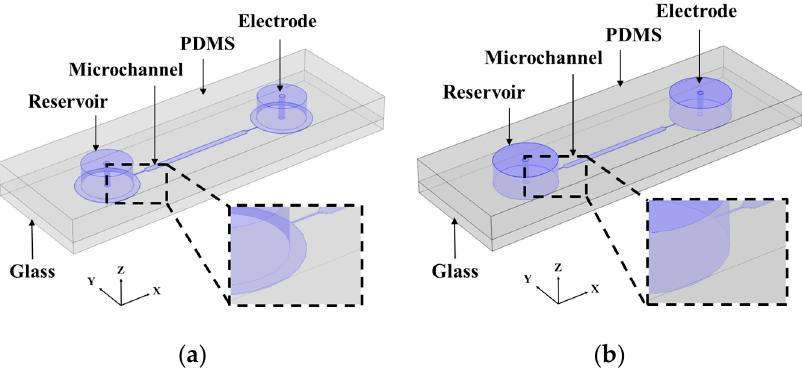
Figure 1. Conceptual schematic of the two-dimensional reservoir-based dielectrophoresis (2DrDEP) and three-dimensional reservoir-based dielectrophoresis (3DrDEP) microfluidic devices. The inset images represent a zoomed view of the reservoir microchannel junction for the device. ( a ) 2DrDEP device fabricated by punching a fluid reservoir within the circular guides patterned as extensions to the microchannel during photolithography. This makes the patterned reservoir-microchannel junction two-dimensional; ( b ) 3DrDEP device fabricated by punching a fluid reservoir directly on the circular guides patterned as extensions to the microchannel during photolithography. This makes the patterned reservoir-microchannel junction three-dimensional.